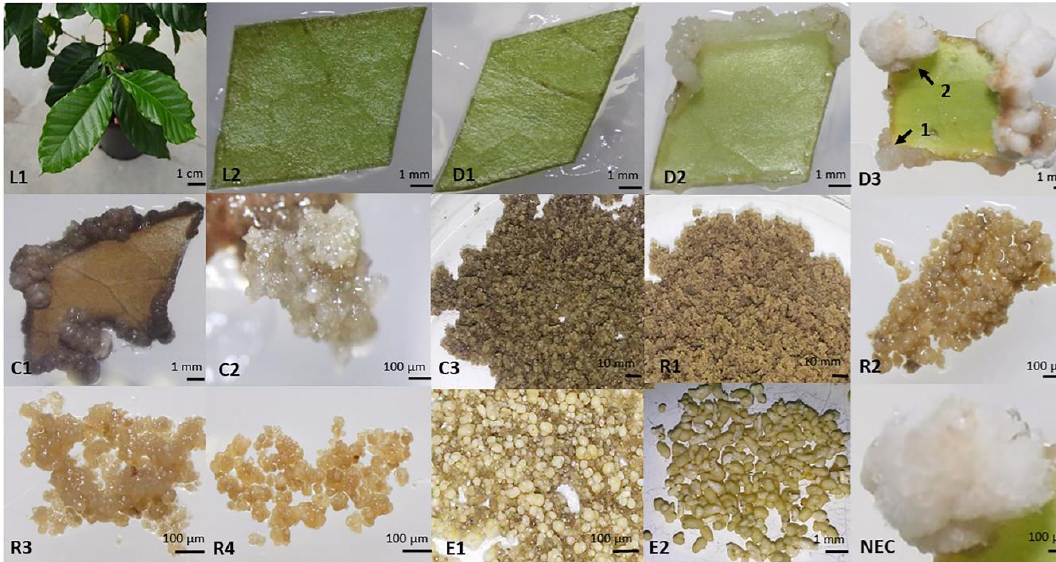
Figure 1. Collection of samples from leaf explant till embryo development covering 14 key sampled stages of the Arabica SE process: leaves from greenhouse plants (L1), explants during dedi ff erentiation [0 h (L2), 1 week (D1), 2 weeks (D2), 5 weeks (D3)], compact primary callus obtained 3 months after induction (C1), embryogenic callus obtained 7 months after induction (C2), established cell clusters obtained after 4 months in proliferation medium (C3), early redi ff erentiation from cell clusters [1 week in DIF medium without reducing cell density (R1), 24 h in DIF medium after reducing cell density (R2), 72 h (R3), 10 d (R4)], globular embryos (E1) and torpedo-shaped embryos (E2). Non-embryogenic callus (NEC) was also sampled at the same time as the embryogenic callus (C2). Images were taken using an Olympus E-5 digital camera mounted on an Olympus SZX7 stereomicroscope. The stereomicroscope was not used for (L1). Two types of calli can be seen in (D3): an organized yellowish callus (1) and a whitish spongy callus